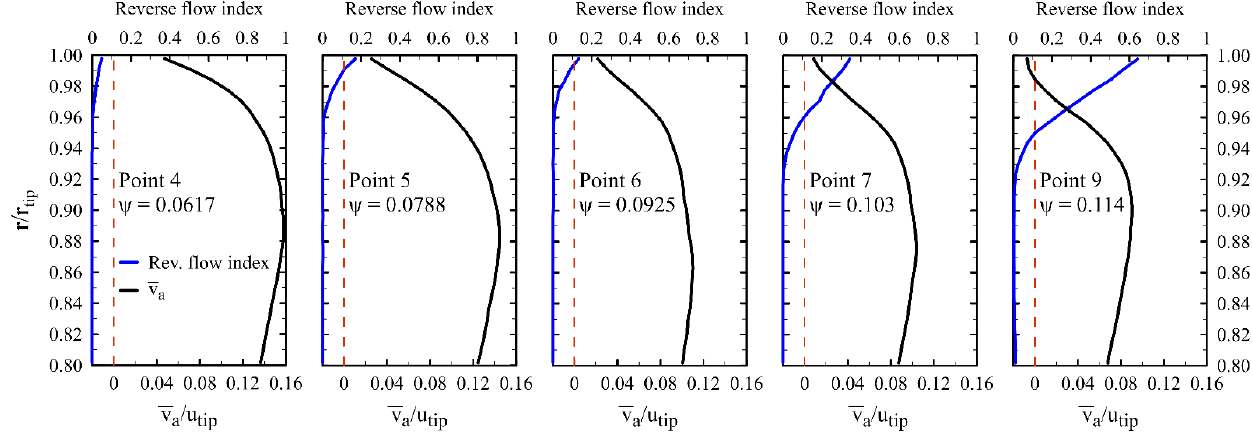
Figure 5. Radial profiles of the reverse flow index, time averaged axial velocity, and turbulence intensity ( x / r tip = 0.0135).